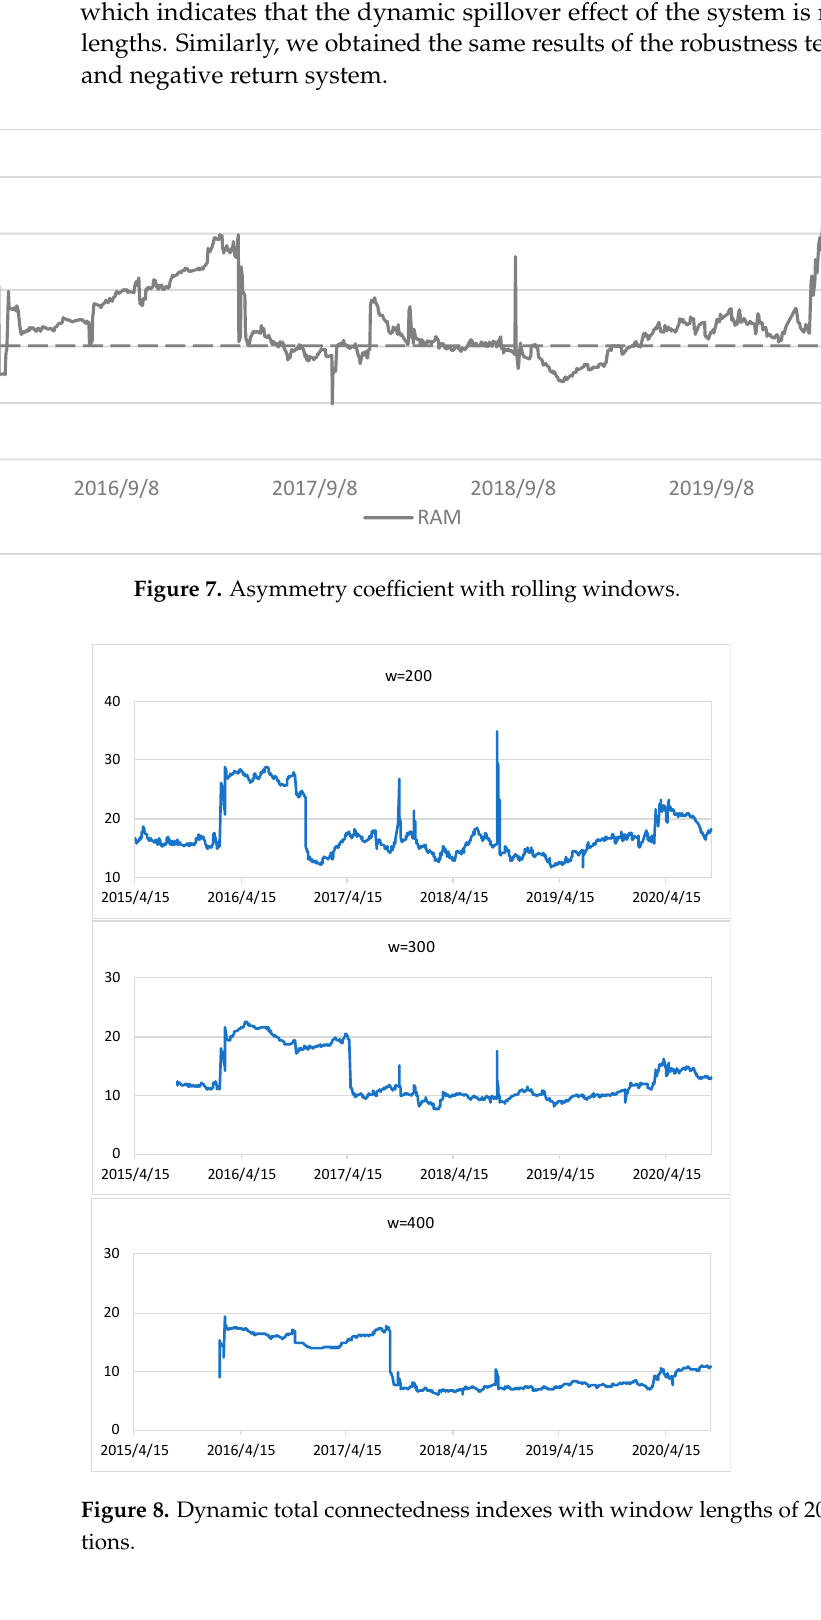
Figure 6. Dynamic total spillover indexes under the positive return system and negative return system.